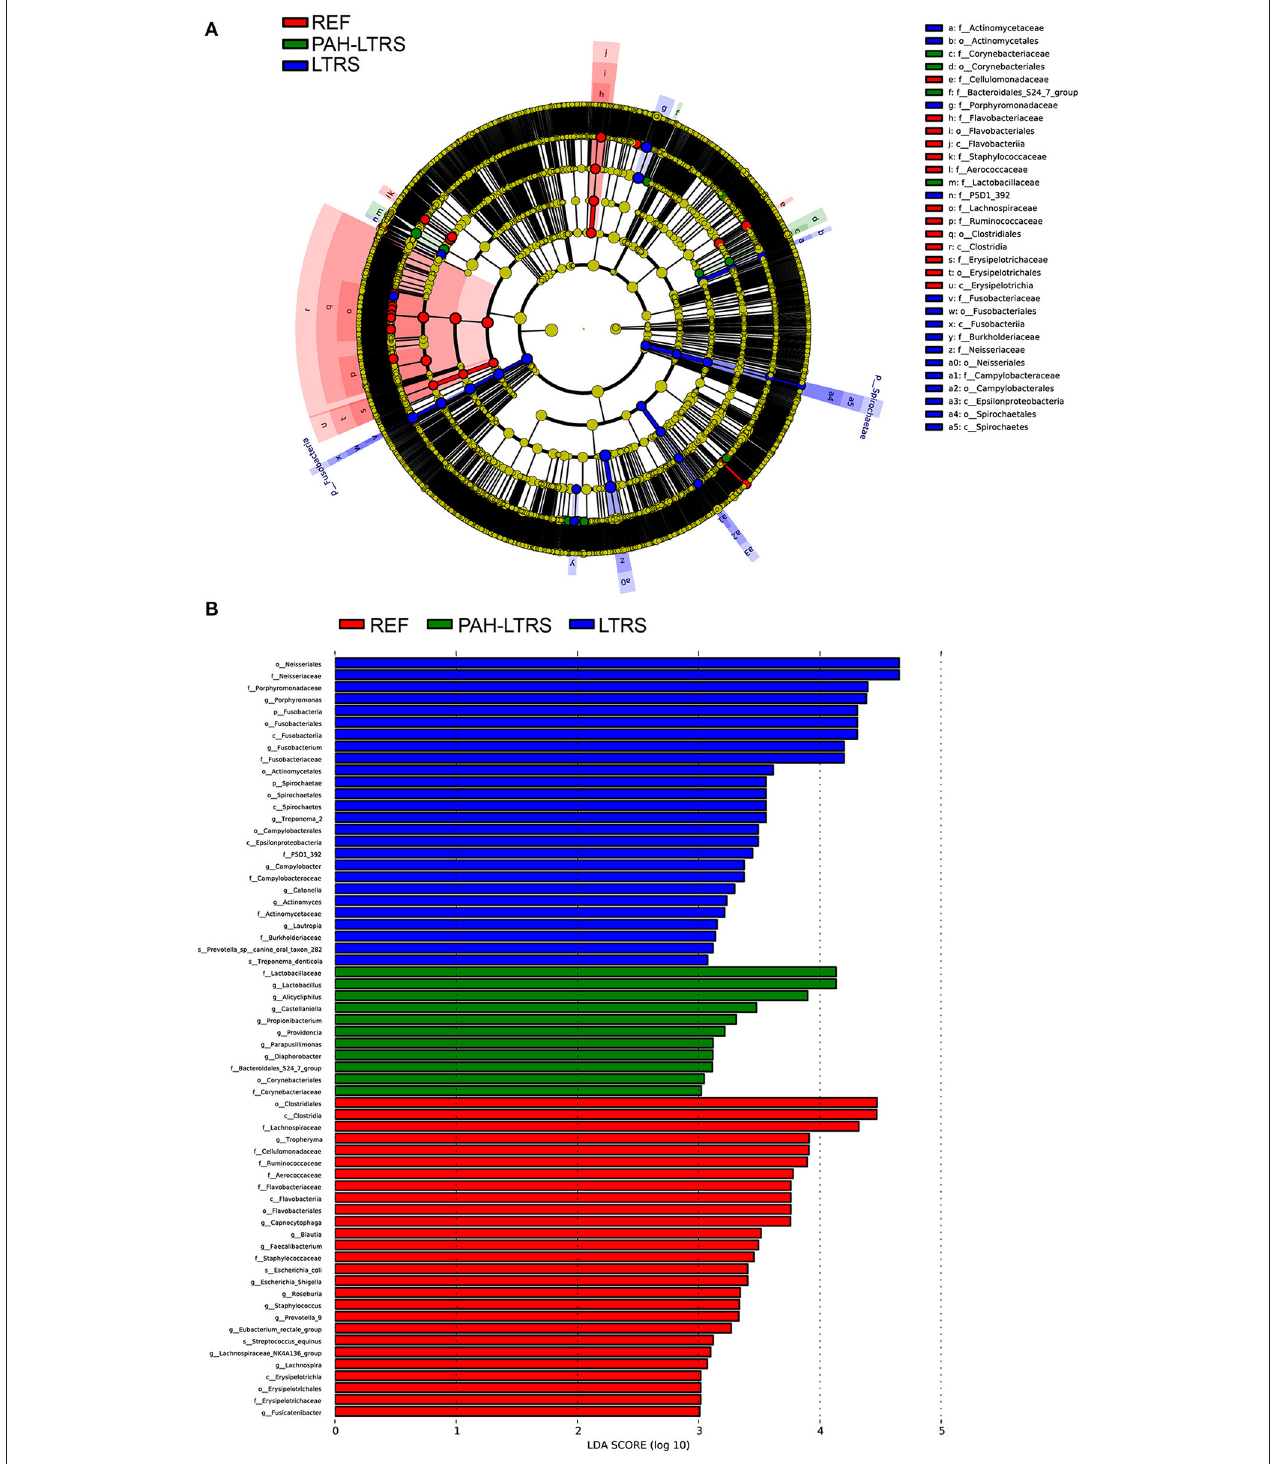
FIGURE 3 | LEfSe analysis to visualize differences in bacterial taxa among different groups. (A) The phylogenetic distribution of significantly enriched bacteria in different groups were showed by the cladogram. Nodes with different color represent different microbial taxa that are significantly abundant in the groups and significantly contribute to the differences between cohorts. (B) LDA bar graphs were utilized to identify the microbiota taxa with potentially significant effects in the three groups. Linear discriminant analysis (LDA, score > 2.0) scores are shown on the x-axis and taxa with the larger LDA score, the greater effect they might have in this group. PAH-LTRS, patients with pulmonary arterial hypertension associated with Left-to-Right shunt ( n = 15); REF, healthy reference ( n = 16); LTRS, patients with Left-to-Right shunts but without PAH ( n = 16).